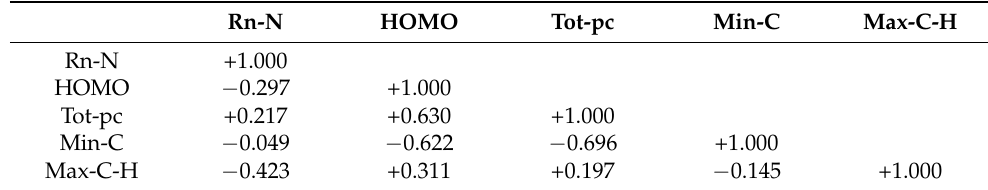
Table 3. Inter-correlation between the five